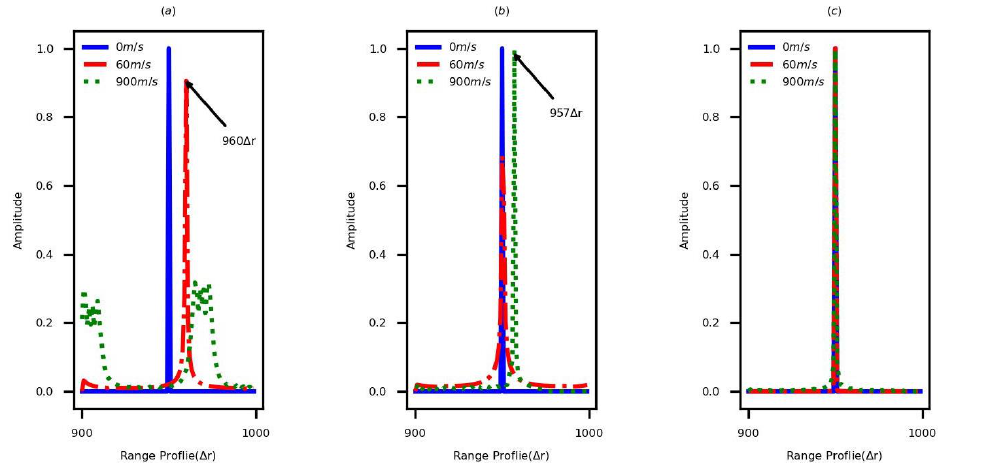
Figure 3. The HRRPs of the single-scattering-point target generated by the normal SF and the sequentially transmitted and cross-transmitted DSF waveforms in different velocities, based on the parameter set 1. ( a ) Normal SF. ( b ) Sequentially transmitted DSF waveform. ( c ) Cross-transmitted DSF